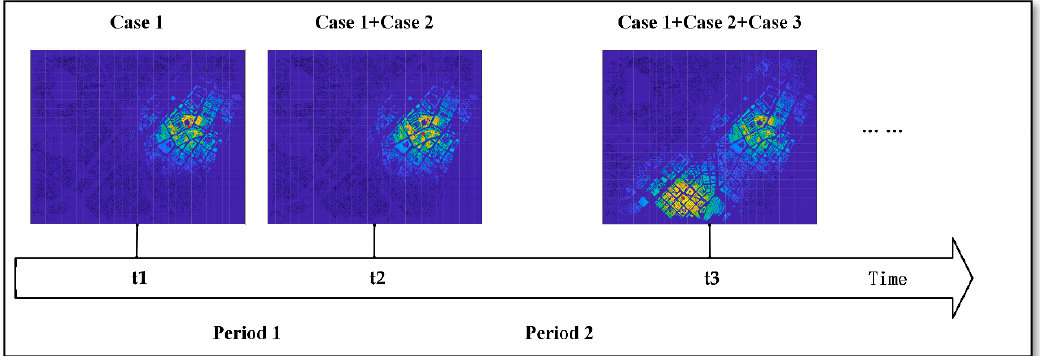
Figure 7. Cumulative crime risk over time.